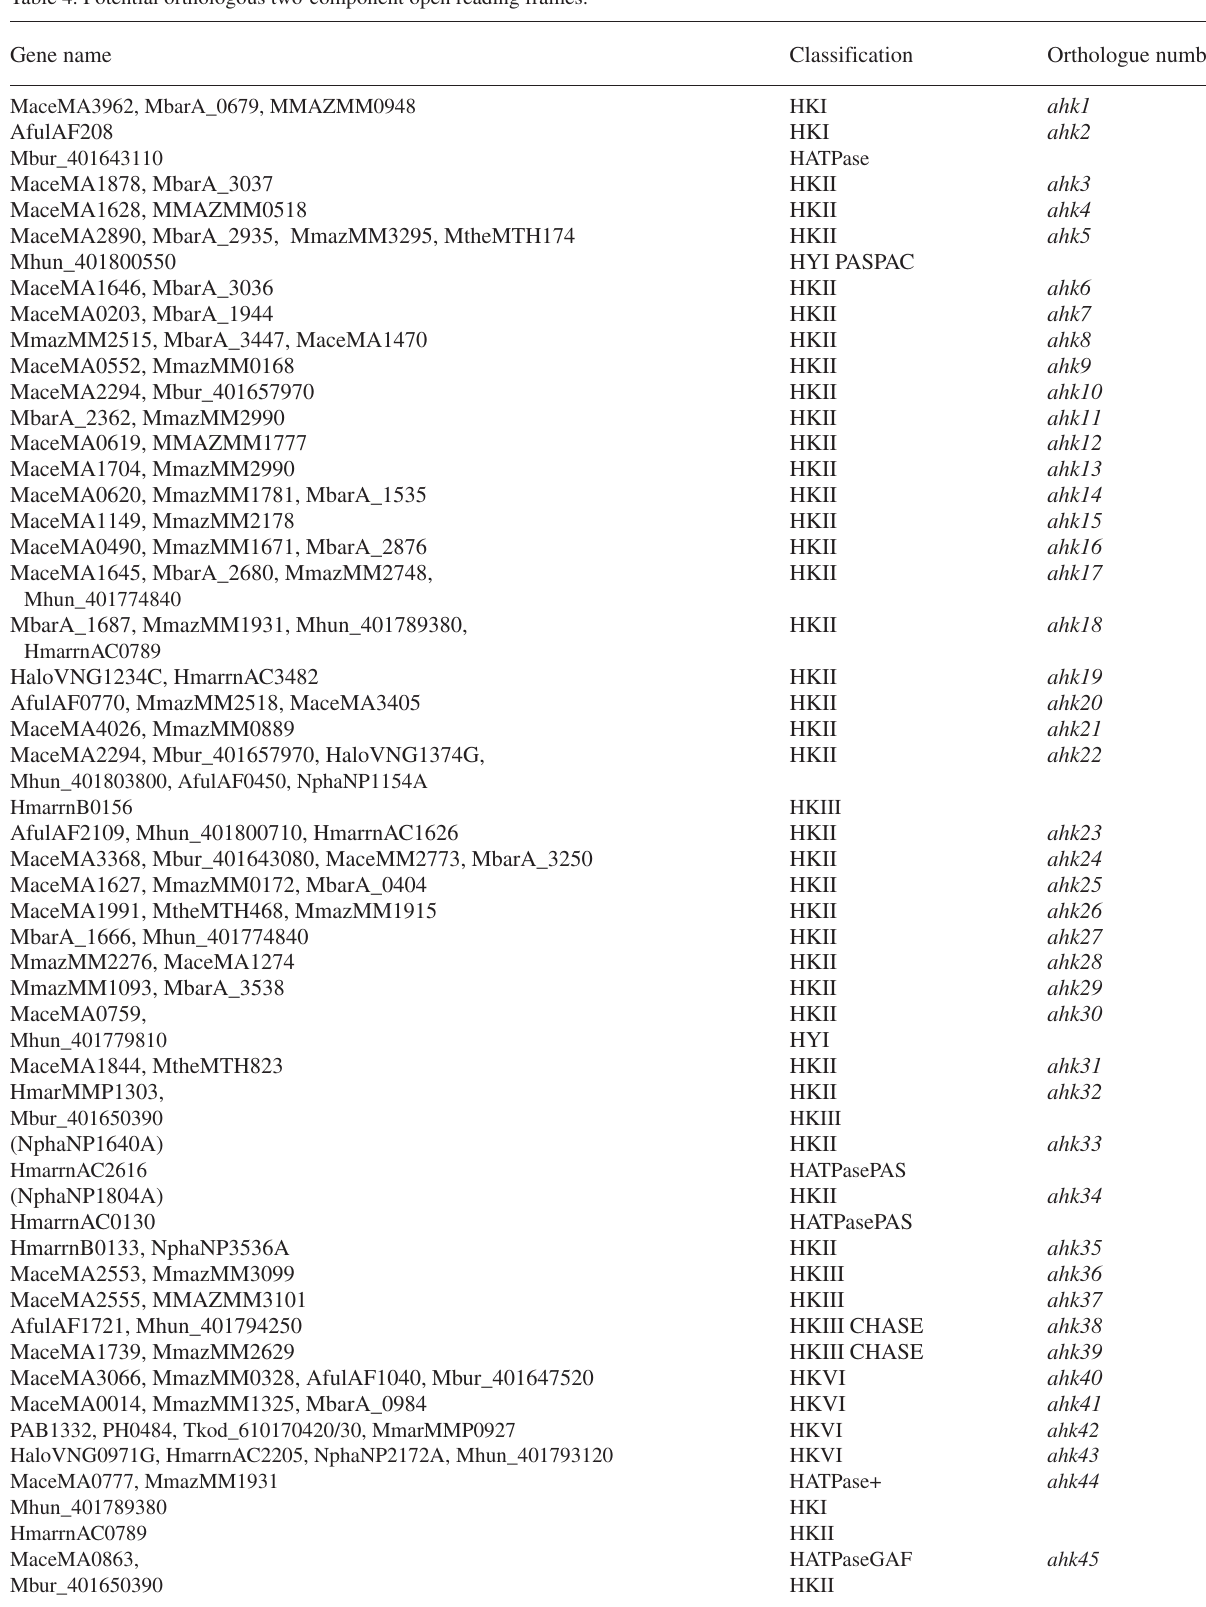
Table 4. Potential orthologous two-component open reading